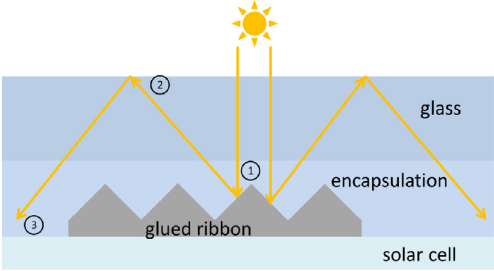
Fig. 1. Optical path of the light for a structured ribbon.